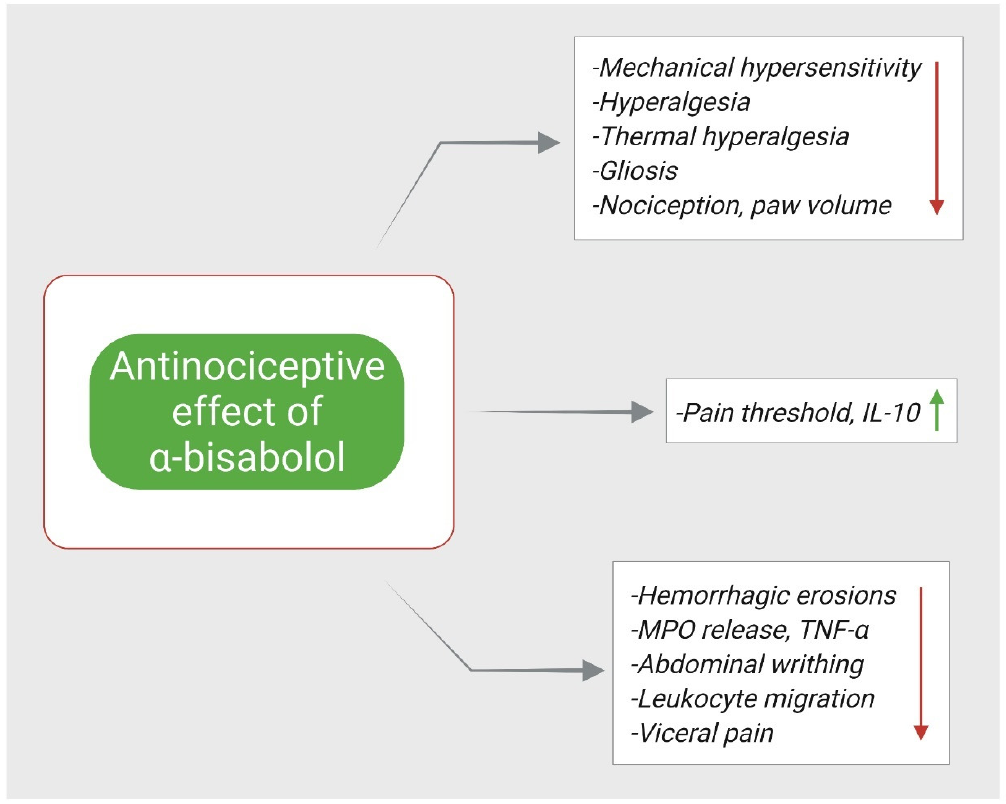
Figure 4. Antinociceptive mechanisms of α -Bisabolol. ↑ ; increase, ↓ ;